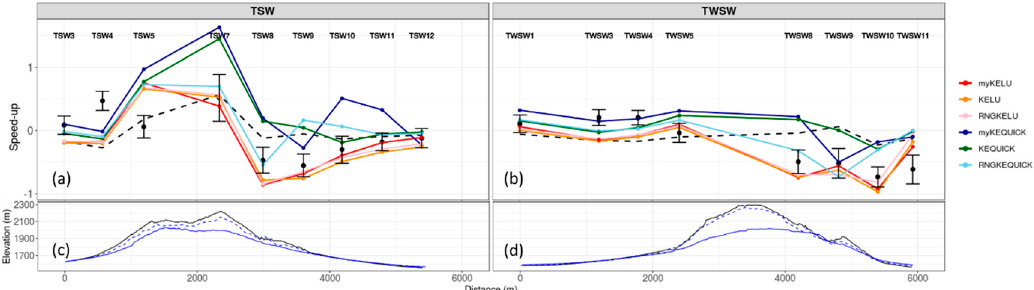
Figure 15. Model comparisons with observed speed-up at Big Southern Butte along transect ( a ) TSW and ( b ) TWSW. DEM and terrain representation in the meshes along transect ( c ) TSW and ( d ) TWSW as shown in Figure 15b,c. The x-axis is distance along the transect. The y-axis in ( a ) and ( b ) is the fractional speed-up, relative to the observed speed at a reference station upwind. Black circles are observed data. Error bars indicate plus and minus one standard deviation. The black dashed lines are the COM solver results.